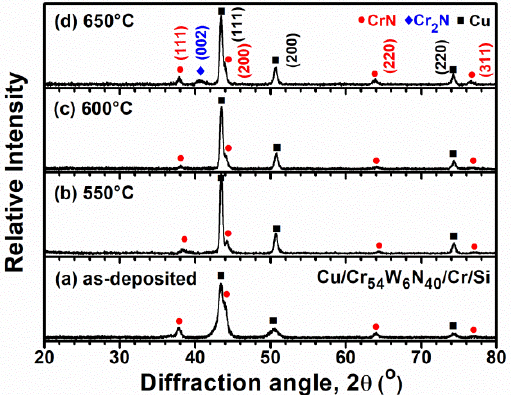
Figure 13. GIXRD patterns of ( a ) as-deposited and ( b – d ) annealed Cu/Cr 54 W 6 N 40 /Cr/Si samples.